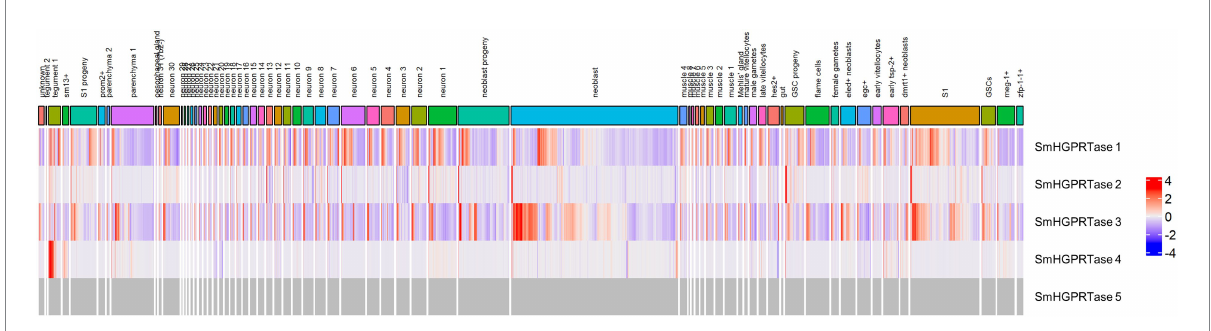
FIGURE 3 SmHGPRTAses expression patterns in different cell types observed in Schistosoma mansoni adult worms. The columns indicate the different cell types identified in adult worms and the lines represent the different SmHGPRTAses analyzed. The color scale indicates higher (red) or lower (blue) expression of transcripts. The undetectable expression is represented in